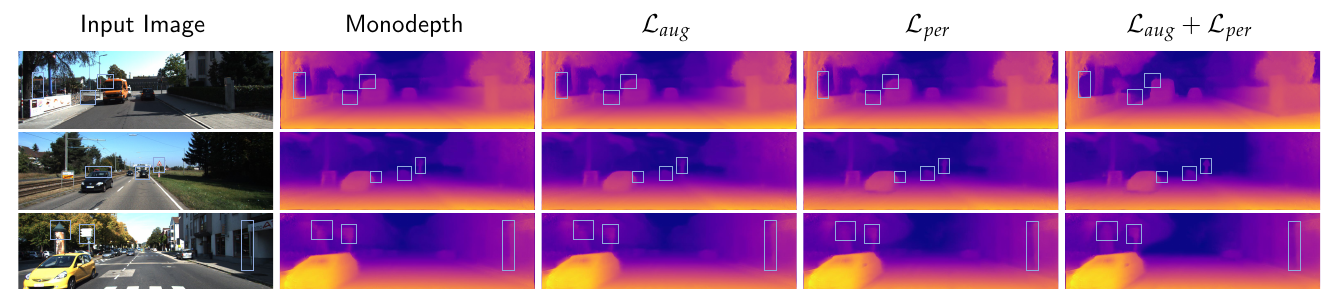
Figure 8. Visualization of ablation study. From left to right: input images, the result of Monodepth, the result of Monodepth with data augmentation consistency, the result of Monodepth with perceptual consistency, and the result of PDANet, where L aug is the data augmentation consistency loss and L per is the perceptual consistency loss. Blue patches show the different effects in detail when applying each module